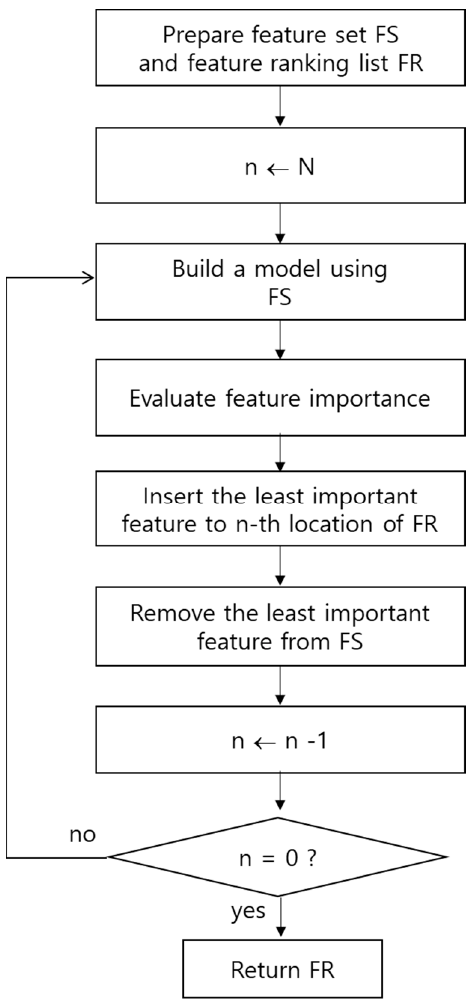
Figure 1. Process of feature-importance-based recursive feature elimination (RFE). N denotes the number of features.